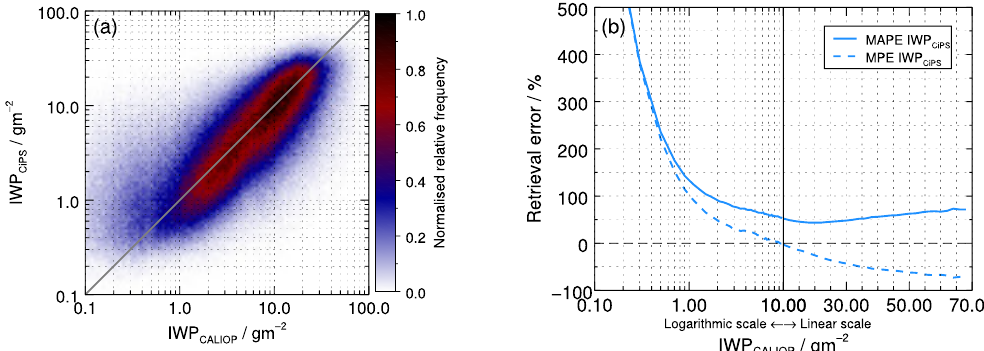
Figure 12. (a) Density scatter plot with the IWP retrieved by CiPS on the vertical axis and the corresponding V3 CALIOP data on the horizontal axis. The grey line represents the 1–1 line. (b) The MAPE (solid) and MPE (dash) of the IWP retrieved by CiPS with respect to the IWP retrieved by